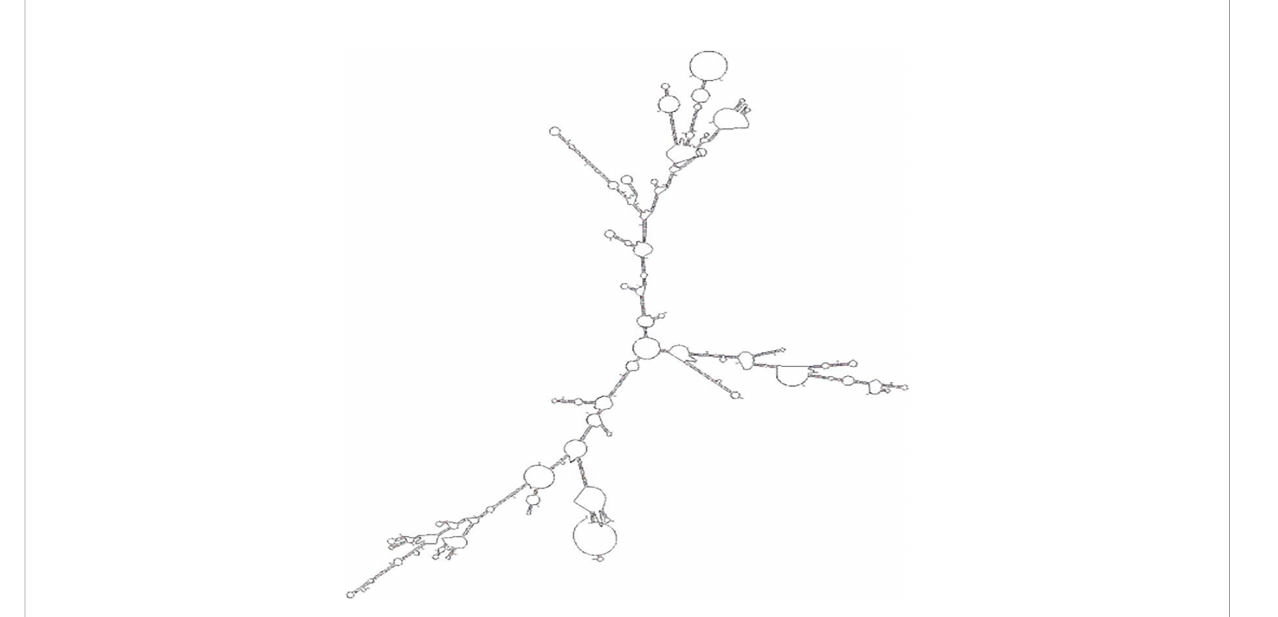
FIGURE 2 The secondary structure prediction for LncMPEG1